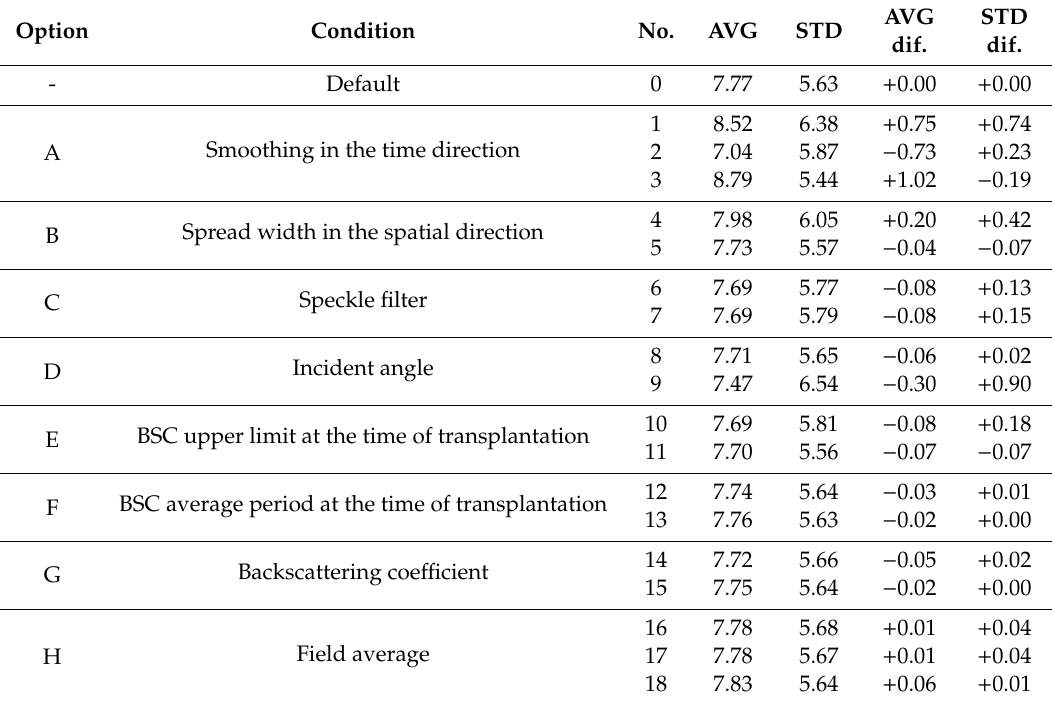
Table 4. Transplanting date estimation